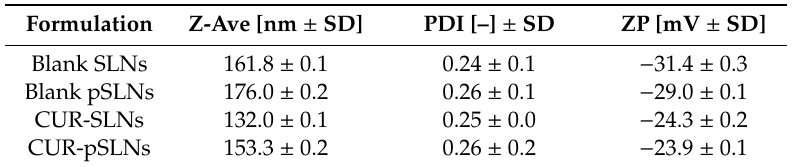
Table 1. The values of Z-Ave, polydispersity index (PDI), and Z-potential for blank solid lipid nanoparticles (SLNs), blank stealth SLNs (pSLNs), curcumin-loaded PEGylated SLN (CUR-SLNs), and CUR-pSLNs recorded at 25 ◦ C. ZP: zeta potential.